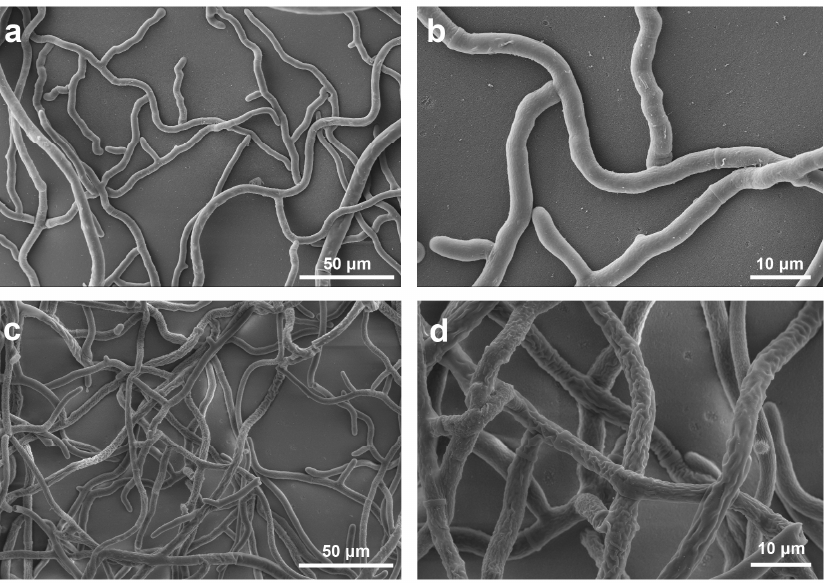
Figure 5. SEM of R. solani hyphae treated with 0 ( a , b ) or 50 μg/mL 18 ( c , d ) .